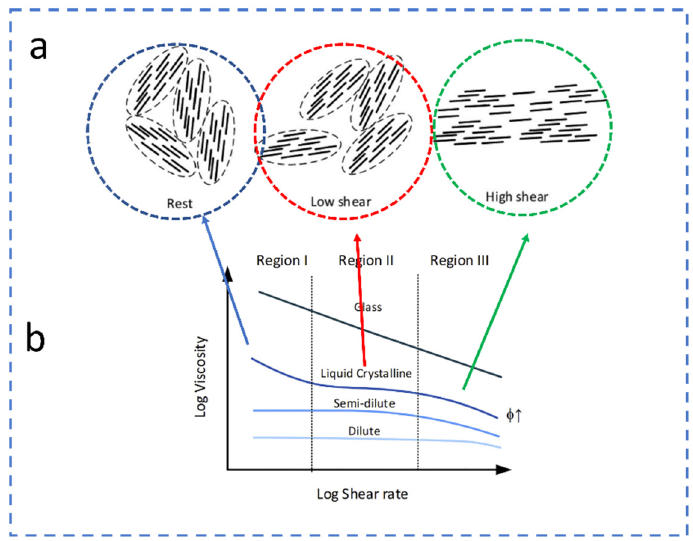
Figure 4. Correlation between mesostructure and rheology of liquid crystalline CNCs. ( a ) Schematic of domain orientation based on lyotropic liquid crystalline theory. ( b ) The shear rate dependence of apparent viscosity for LC, dilute, semi-dilute, liquid crystalline and glassy rod’s suspension. Adapted with permission from Ref [33]. Copyright 2019 Elsevier B.V.